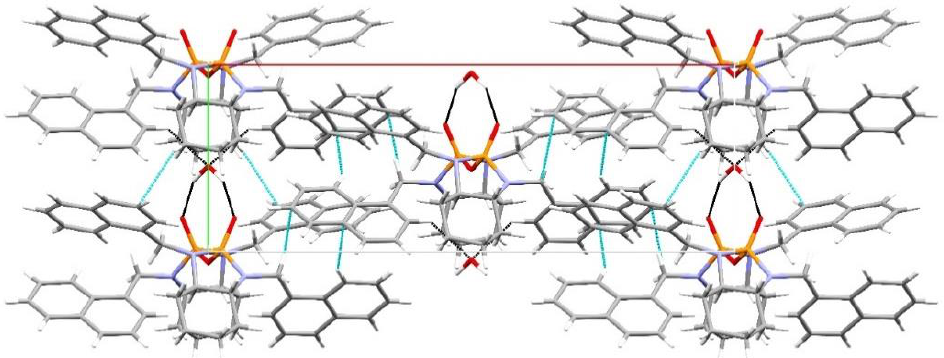
Figure 14. Structure of O((1,2-Cy(NaphN) 2 ) 2 PO) 2 viewed along the c-axis showing hydrogen bonding (black contacts) and C–H ··· Ph interactions (light blue contacts) (generated in Mercury [25]).